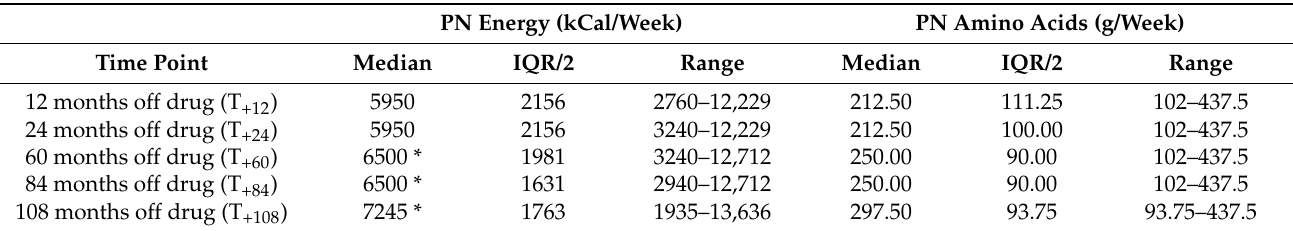
Table 4. Weekly parenteral nutrition (PN) energy and amino acid content in the study sample after stopping teduglutide